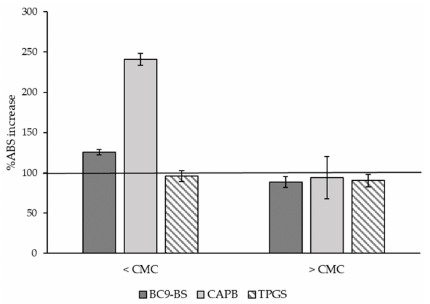
Figure 3. Surfactants interaction with mucin as function of their concentration. Data are reported as percentage increase of the sample absorbance ( ABS) in the presence of mucin with respect to the same sample without mucin, and are expressed as means ± SD, n =